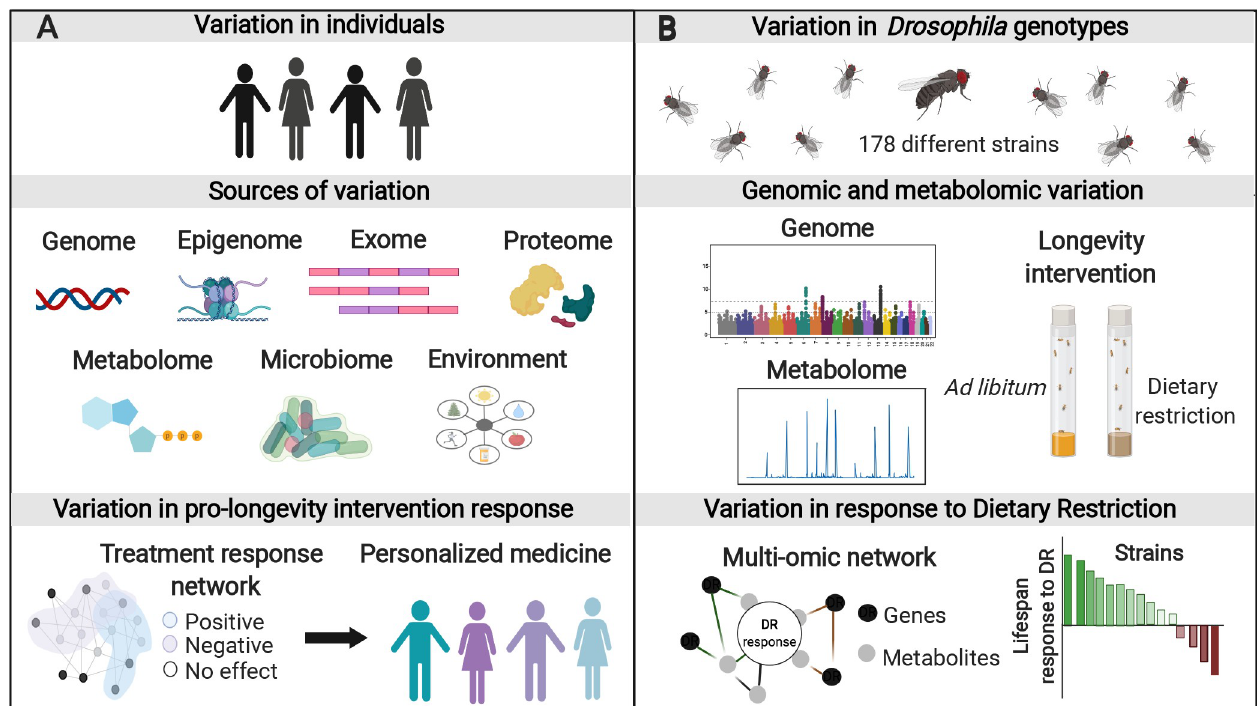
Fig 1. Multi-‘omic’s network-based approach towards precision geroscience. (A) Within population heterogeneity in the response to prolongevity interventions limits their therapeutic use. Multiple sources contribute to the variation in response to treatment: from genotype to microbiome, along with interaction with the environment. Information from all sources can be integrated in biological multi-‘omic’s networks that more accurately inform and predict an individual’s response to treatment as a pathway toward precision geroscience. (B) In an inbred, genetically heterogeneous population of fruit flies subject to DR, Jin and colleagues [11] integrated gene-level GWAS with metabolic profiling to build multi-‘omic’s network that display specific gene-to- metabolite-to-phenotype pathways directly associated with DR response. DR, dietary restriction; GWAS, genome-wide association study.